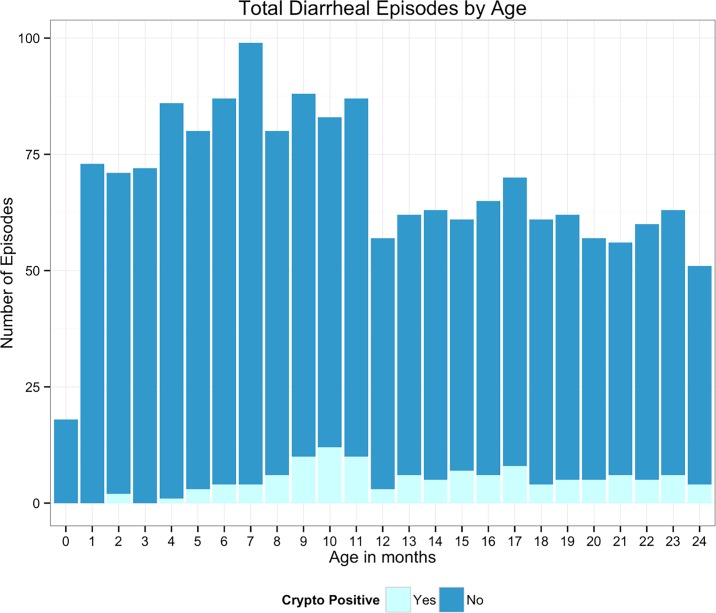
Total number of diarrheal episodes per month.The x-axis represents the child’s age in months, and the y-axis represents total number of diarrheal episodes per age-month. The dark blue segment represents number of total diarrheal episodes, and the light blue segment represents the proportion of diarrheal episodes per month that test positive for Cryptosporidium species. In each month, the total possible number of children included is 392. Cryptosporidium infection makes up a very small portion of the total burden of diarrhea in our cohort.